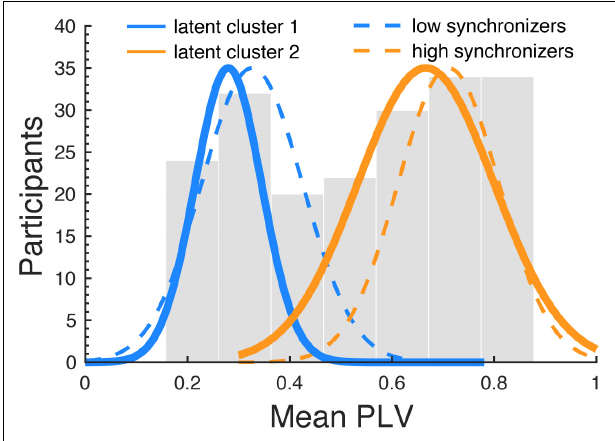
FIGURE 6 | Distribution of the clusters revealed from the latent class regression analysis. The histogram shows the distribution of the mean PLVs (averaged across runs) computed between the speech production and perceived audio signals, for the whole sample (including the samples of both studies). The dashed blue and orange lines indicate normal distributions fitted to the cluster revealed by the k-means algorithm segregating two clusters (HIGHs and LOWs); the thick blue and orange lines indicate the clusters revealed by the latent class regression analysis. The two clusters highly overlap for the different